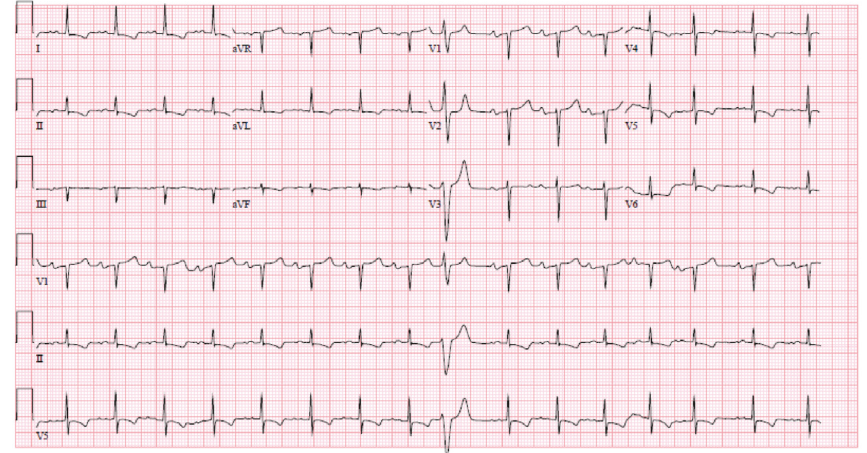
Figure 2: Patient’s ECG from 2 years previously with similar findings to the ECG on